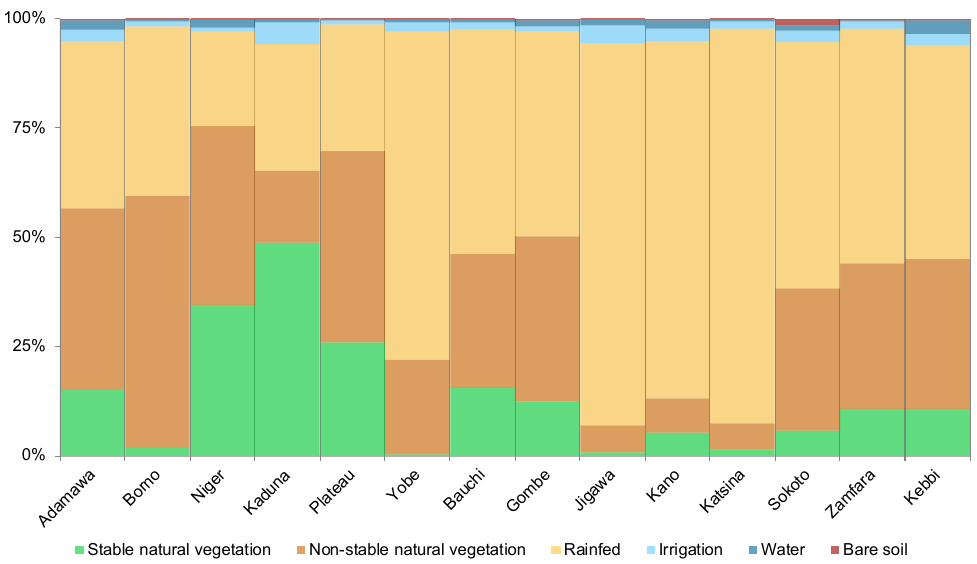
Figure 6. Land cover land use distribution in northern Nigeria by state.